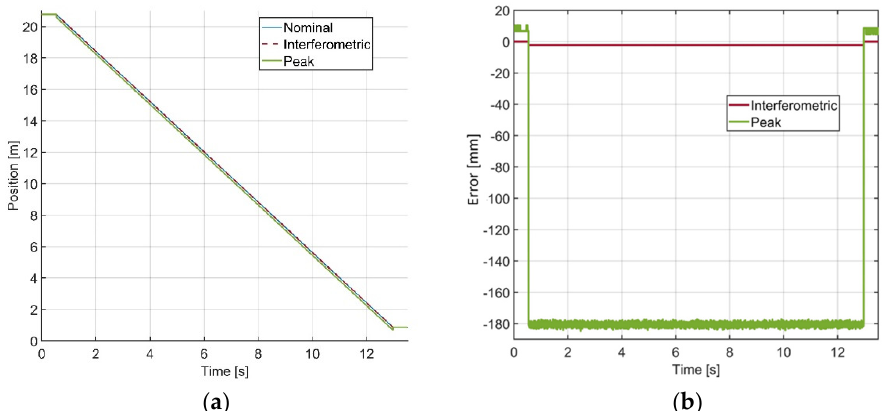
Figure 5. Position retrieved by radar: ( a ) using the interferometric method (green line) and using the peak position (red line); ( b ) error with respect to the nominal position.